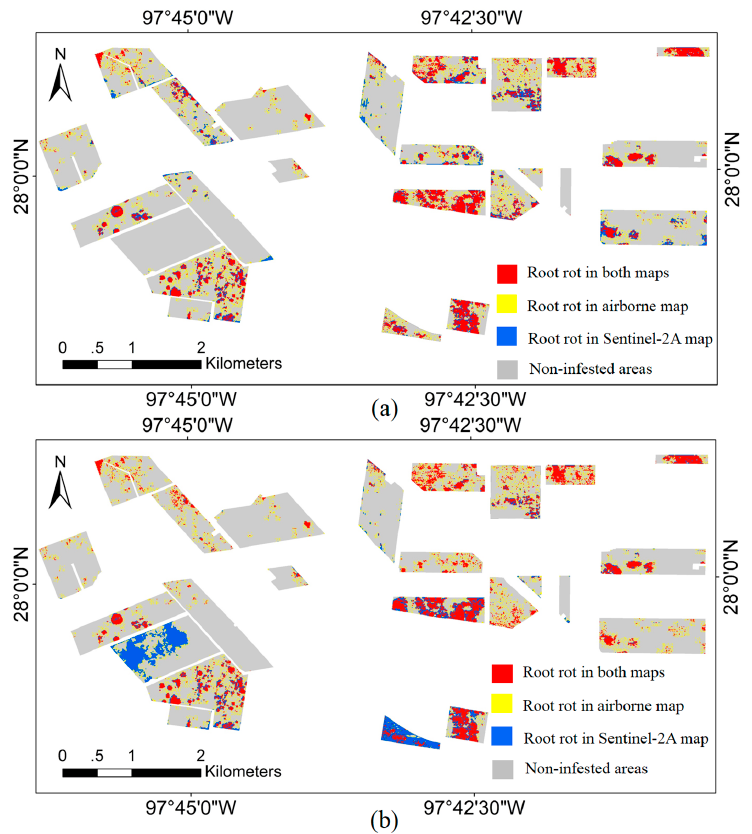
Figure 8. Overlaid cotton root rot classification maps: ( a ) generated from airborne image and field subset Sentinel-2A images; ( b ) generated from airborne image and whole study area Sentinel-2A